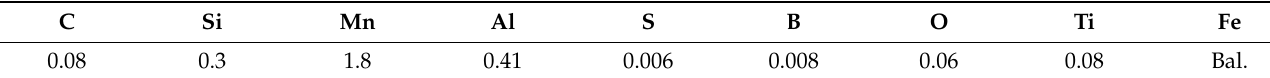
Table 1. Chemical composition of the weld metal (mass (%)).